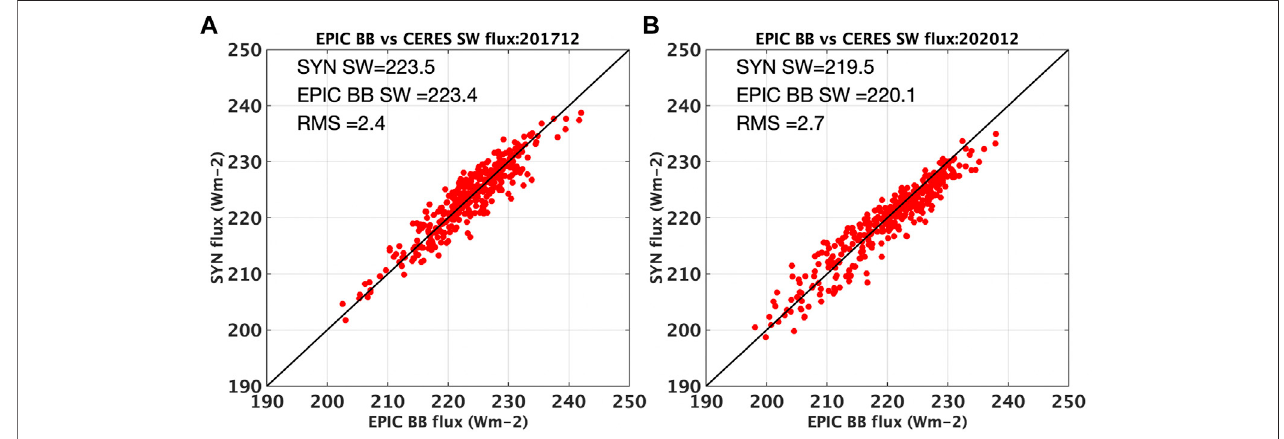
FIGURE 12 | Comparison of global daytime mean shortwave fl ux between EPIC and CERES SYN for December 2017 (A) and December 2020 (B) .